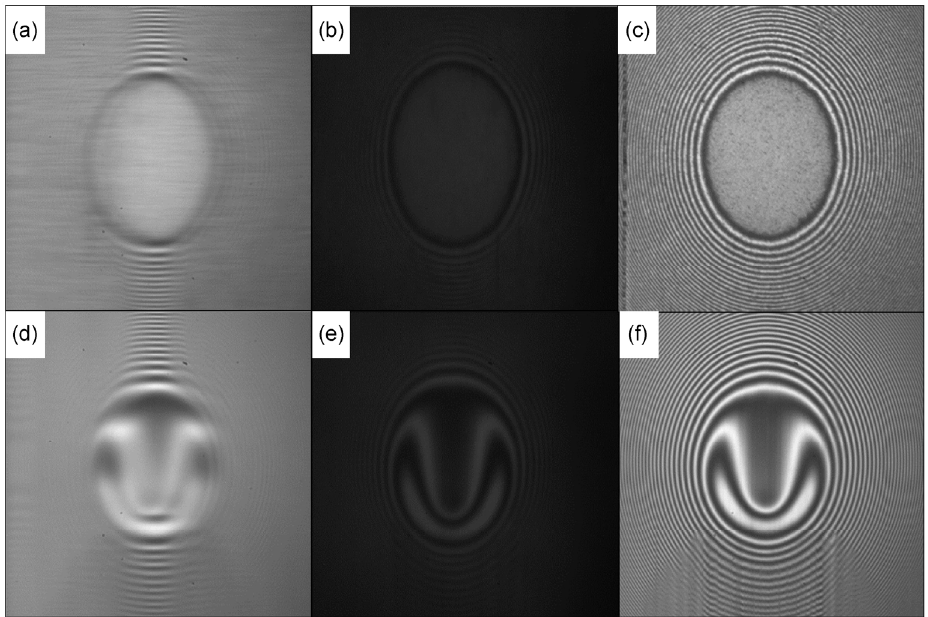
Fig. 8 Interference images captured by: (a, d) uncorrected system; (b, e) uncorrected system with small aperture diaphragm; (c, f) corrected system, at rest (a, b, c) and at the speed 5 m/s (d, e,